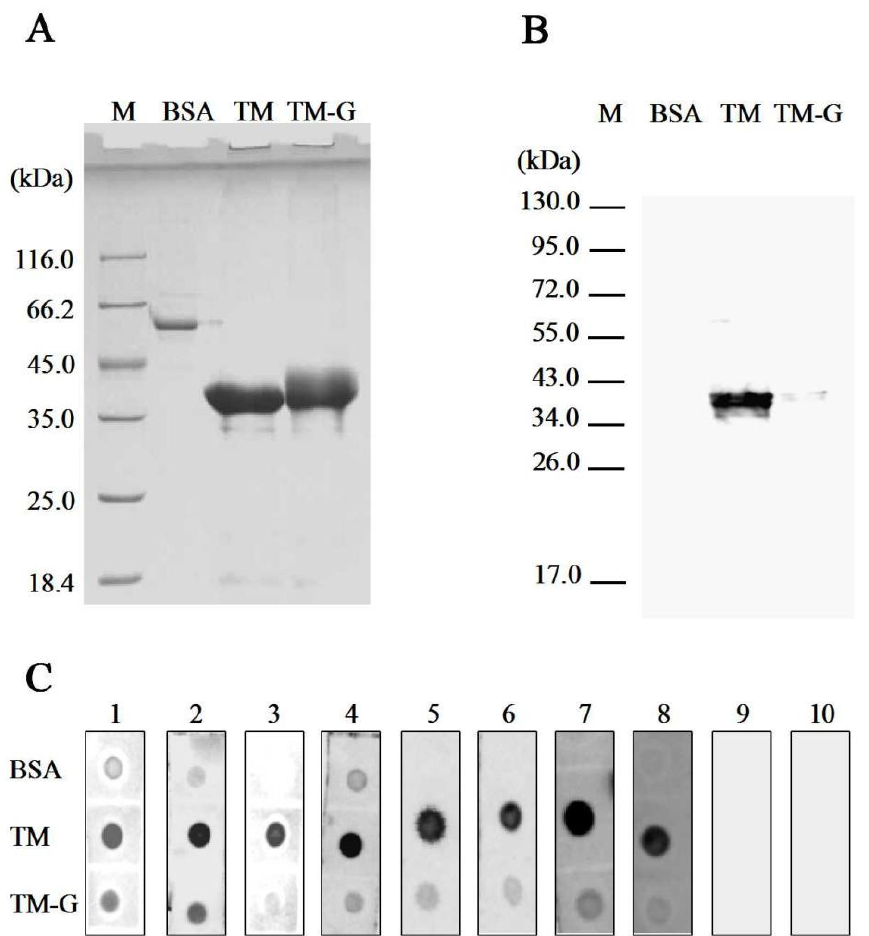
Figure 1. Immunoactivity analysis of TM-G: ( A ) SDS-PAGE analysis of TM-G. Lane M: protein marker. ( B ) IgG-binding capacity analysis of TM-G. Primary antibody: crab-TM-polyclonal anti- bodies, dilution 1: 1 × 10 4 . Lane M: protein marker. ( C ) IgE-binding capacity analysis of TM-G.